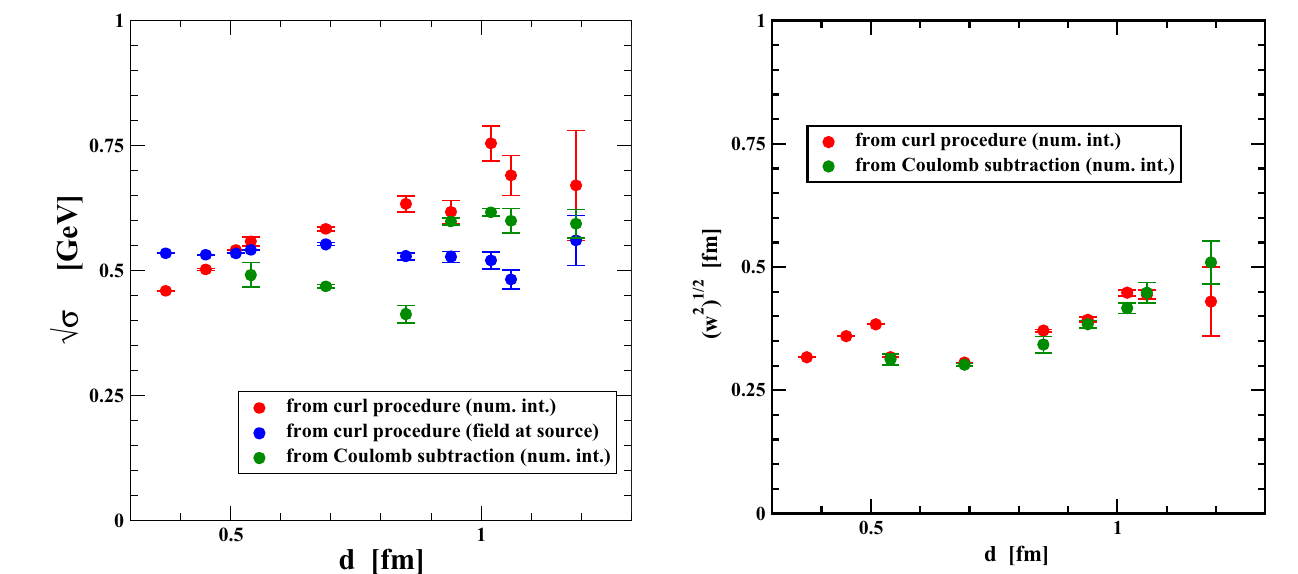
Fig. 10 The mean square width of the flux tube obtained using several different procedures: (i) by numerical integration of Eq. (12) with the non-perturbative field obtained from the curl procedure (Sect. 4); (ii) by numerical integration of Eq. (12) with the non-perturbative field obtained from the Coulomb subtraction (Eq.